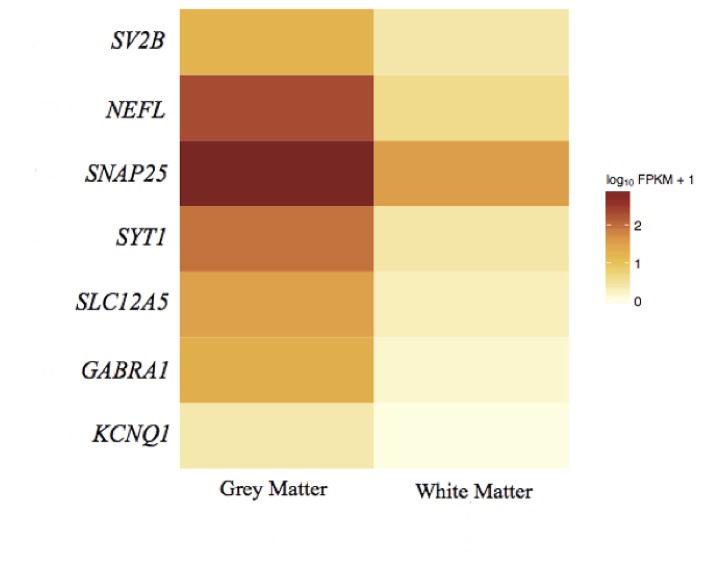
Heatmap of gene expression of neuronal cell markers.Shows the expression profile of neuronal cell markers in GM and WM. There was an expression bias towards GM with the up-regulation of NEFL, GABRA1, SYT1, SLC12A5, SV2B being statistically significant (q-value<0.05).